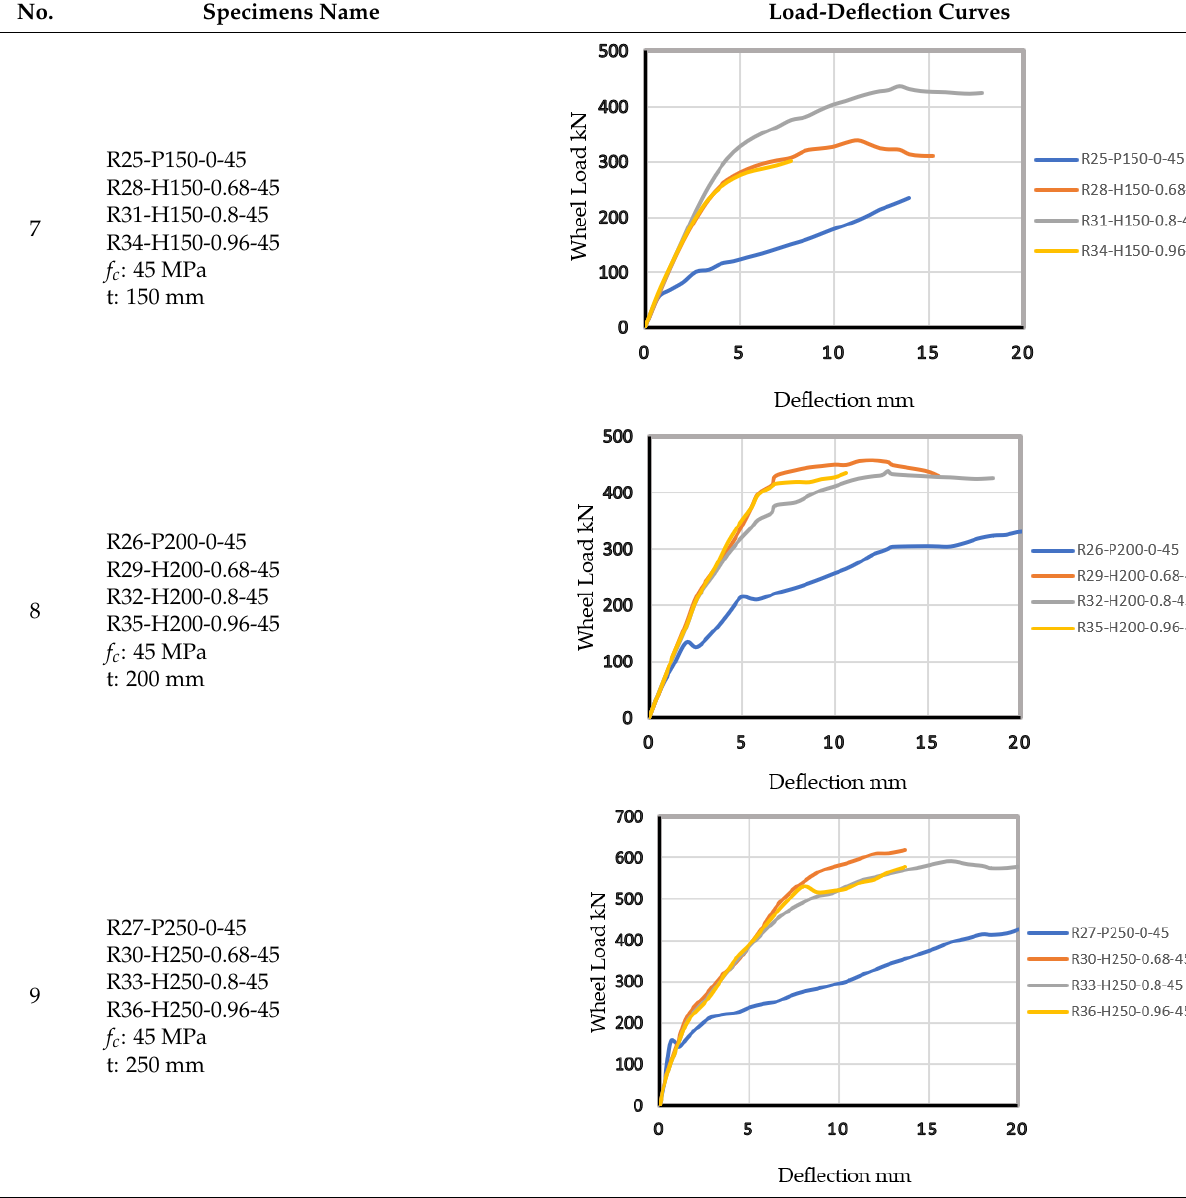
Table A2. Displays the finite element cracks pattern of the rigid pavement specimens .